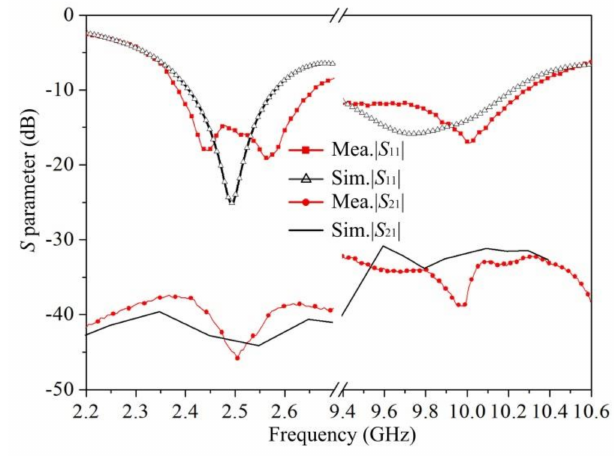
Figure 10. Simulated and measured S parameters.